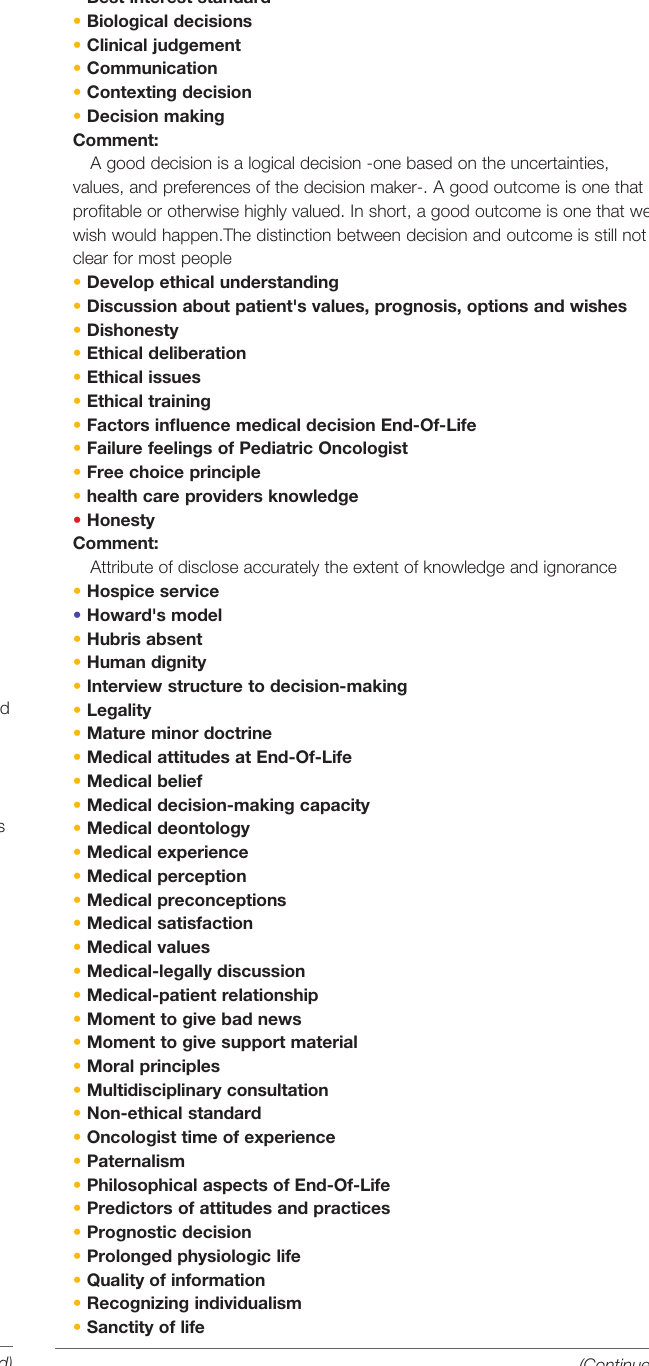
TABLE 5 | Atlas.ti ® code groups. ATLAS.ti Report Bioethical discernment at the End-Of-Life in children with cancer Group of codes Created by Luis Juarez on 12 sep 2021 Clinical determinants at End-Of-Life for Decision-Making 4